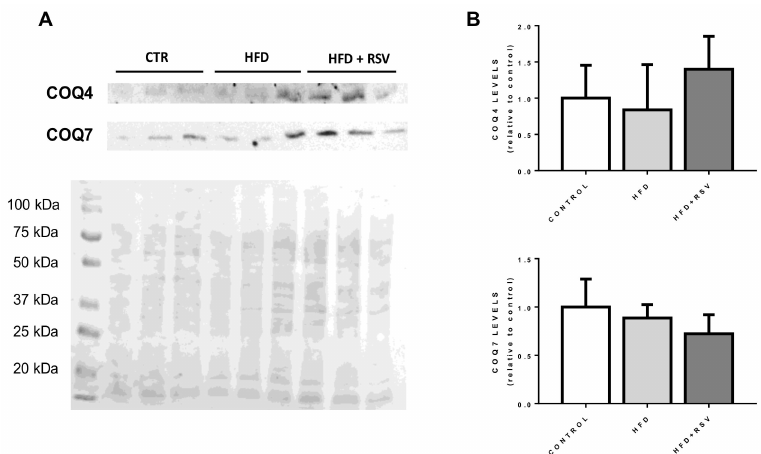
Figure 3. Protein levels of COQ4 and COQ7 in liver mitochondria. ( A ) Representative western blottings for COQ4 and COQ7 proteins in mitochondrial extract of liver mitochondria and Ponceau S loading marker. Lanes include the samples from di ff erent animals belonging to the three groups. ( B ) Quantification of WB relative to control levels ( n = 4). CTR: control.